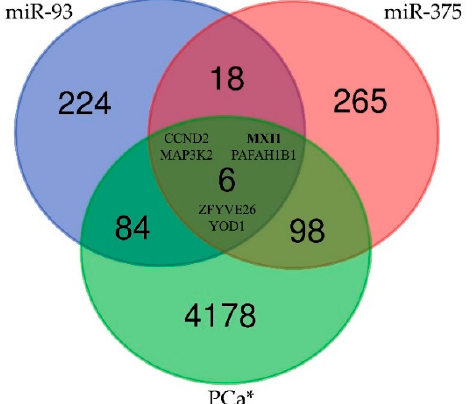
Figure 4. A Venn diagram of the relationships between and among miR ‐ 93, miR ‐ 375 and genes correlated with PCa indicating six target genes; *: genes in The Human Protein Atlas [64].